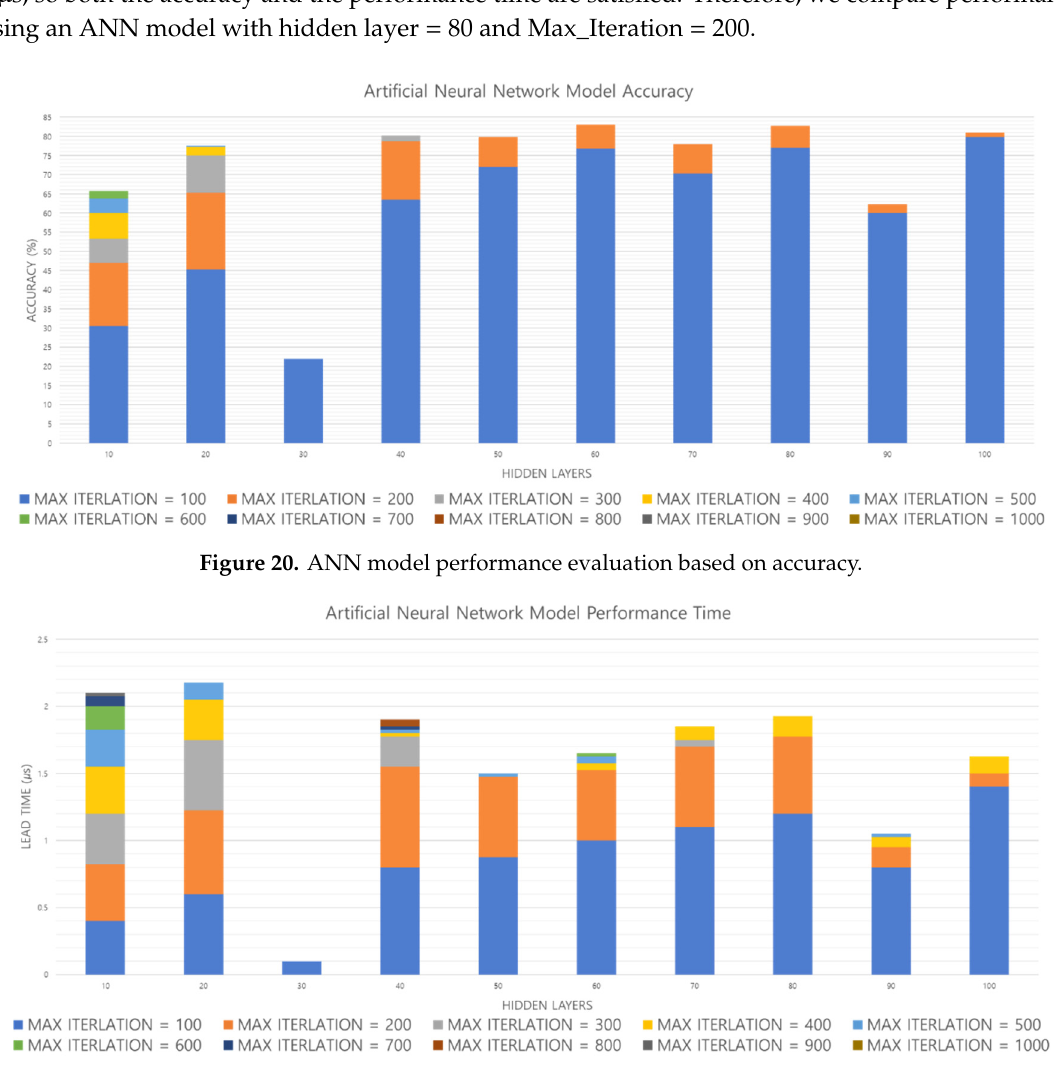
Figure 19. Performance evaluation of K-NN algorithm.